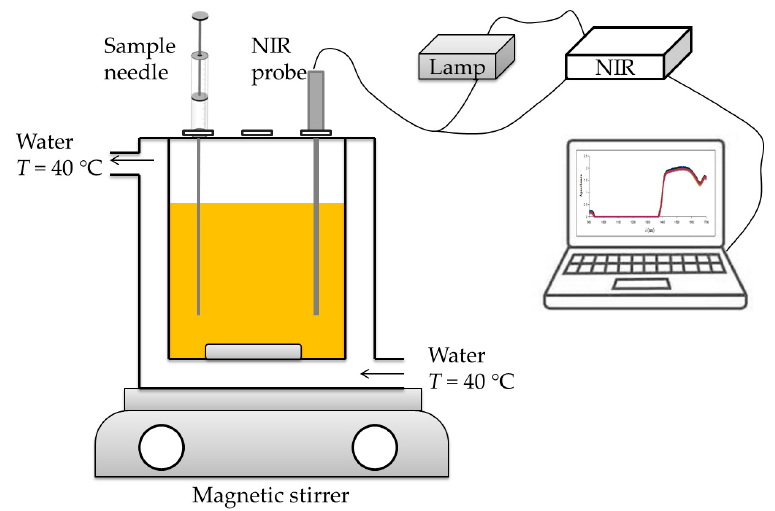
Figure 1. Experimental set-up used for biodiesel production in a batch reactor.